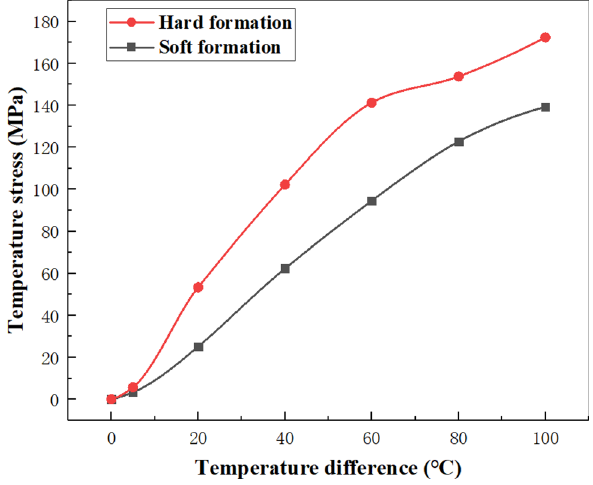
Fig. 14 Variation curve of casing temperature stress with temperature